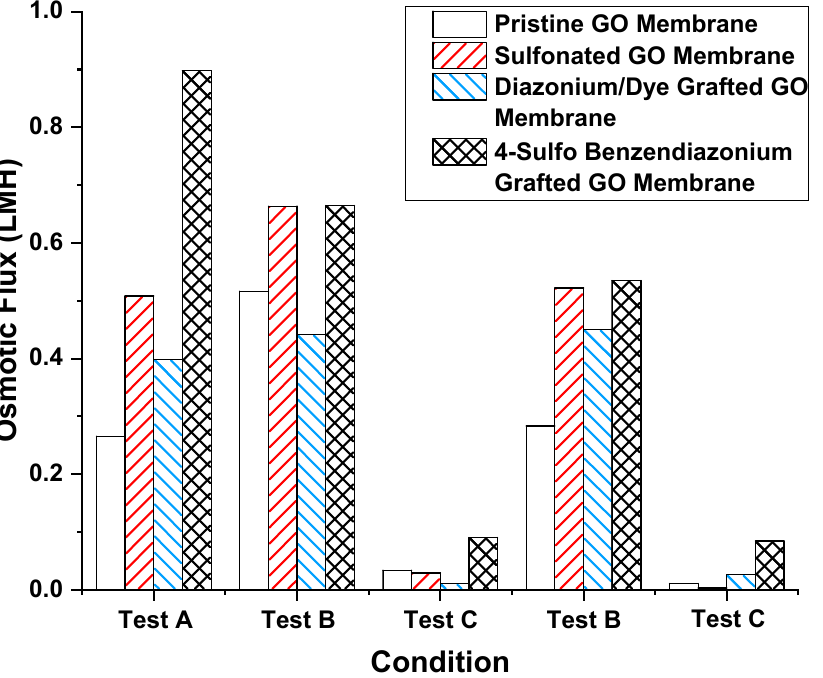
Figure 4. Osmotic flux of different chemical-treated GO membranes under different sequential test conditions. Test A: feed: 10 mM NaCl in water, draw: 1 M NaCl in water; test B: feed: 10 mM NaCl in water, draw: 10 mM NaCl in water–IPA mixture; test C: feed: 10 mM NaCl in water–IPA mix-